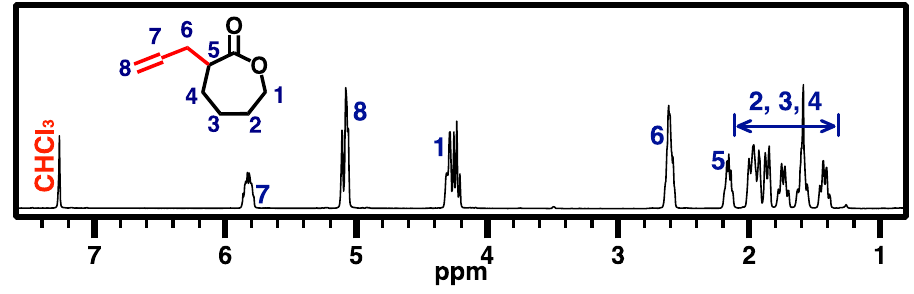
Figure 2. 500 MHz 1 H NMR spectrum of ACL ( 1 ) in CDCl 3 .